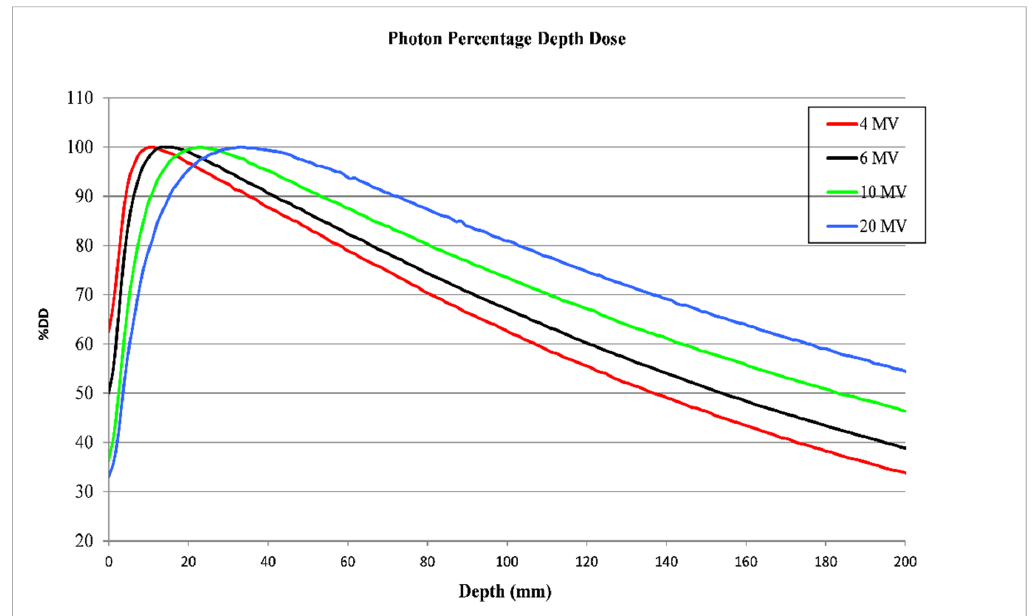
Figure 1. The percentage depth doses from 4, 6, 10, and 20 MV photon beams in a 10 × 10 cm field.